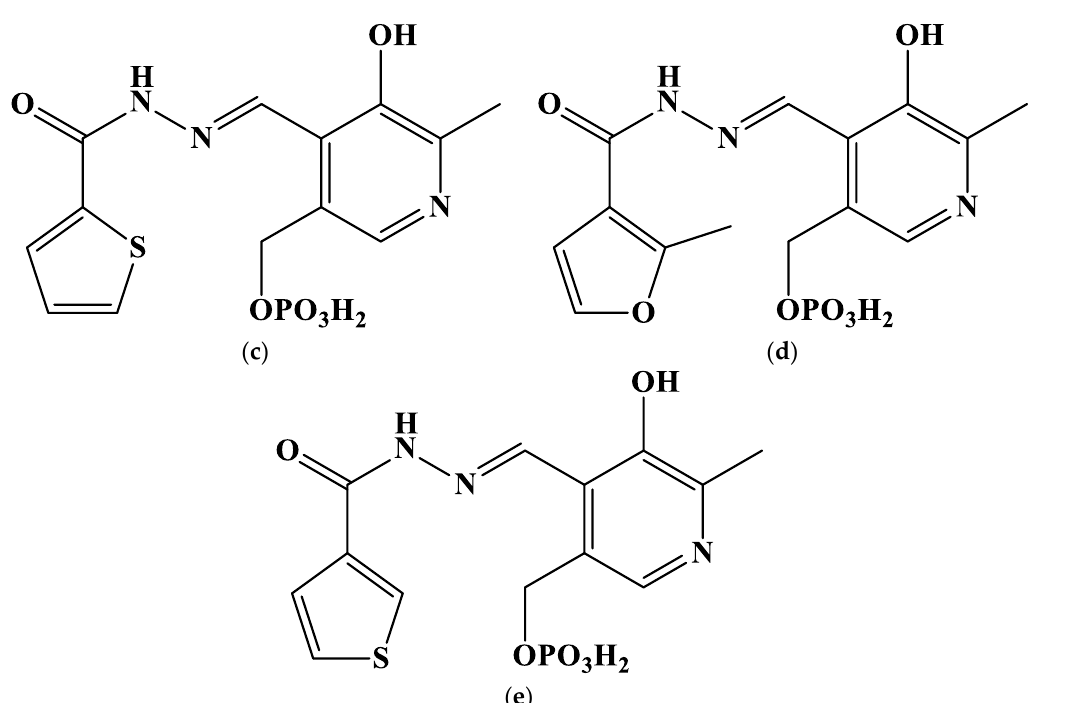
Figure 1. Structures of the studied hydrazones derived from pyridoxal 5′ -phosphate and ( a ) isoniazid ( PLP-INH ); ( b ) furoyl-2-hydrazide ( PLP-F2H ); ( c ) thiophene-2-carbohydrazide ( PLP-T2H ); ( d ) 2-methylfuroyl-3-hydrazide ( PLP-F3H ); ( e ) thiophene-3-carbohydrazide ( PLP-T3H ).